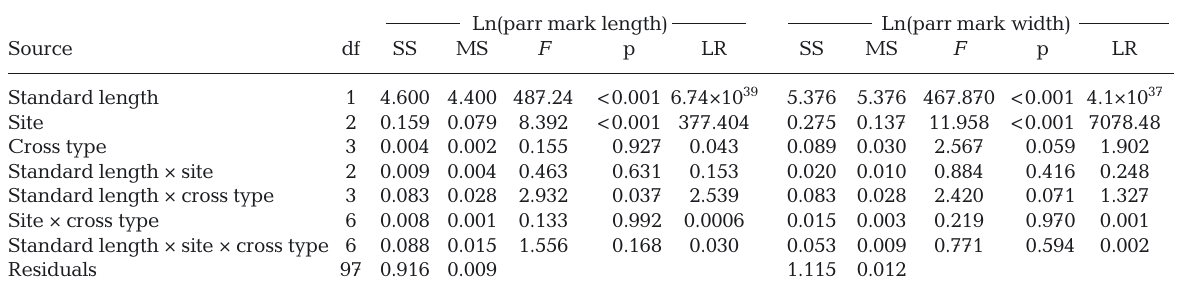
2. ANOVA results of the linear model for mean Atlantic salmon parr mark length below lateral line, and mean mark width by site and cross type. The standard length covariate was ln transformed prior to model analysis. LR: likelihood